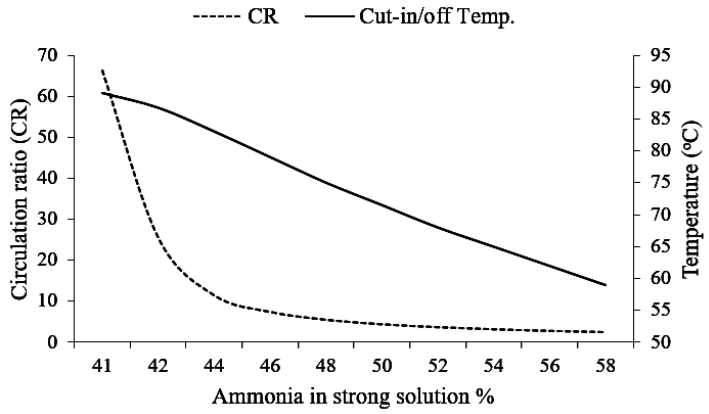
Figure 4. Effect of X ss on circulation ratio (CR) and cut in/off